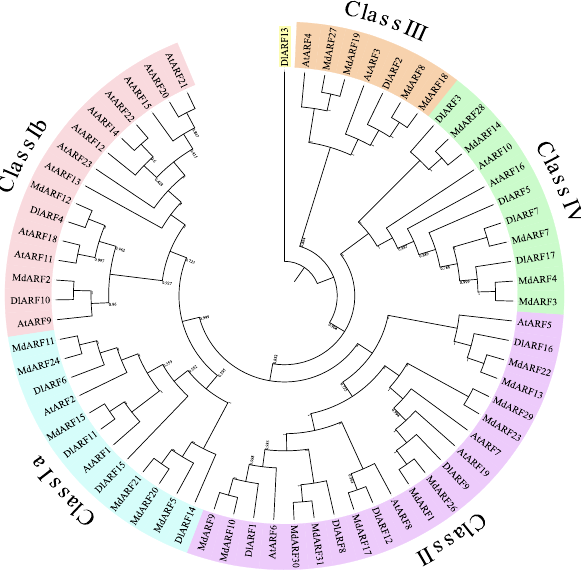
Figure 2. The phylogenetic analysis of ARF family genes of Arabidopsis , apple, and longan. Tree was constructed via neighbor-joining method with 1000 bootstrap replications.